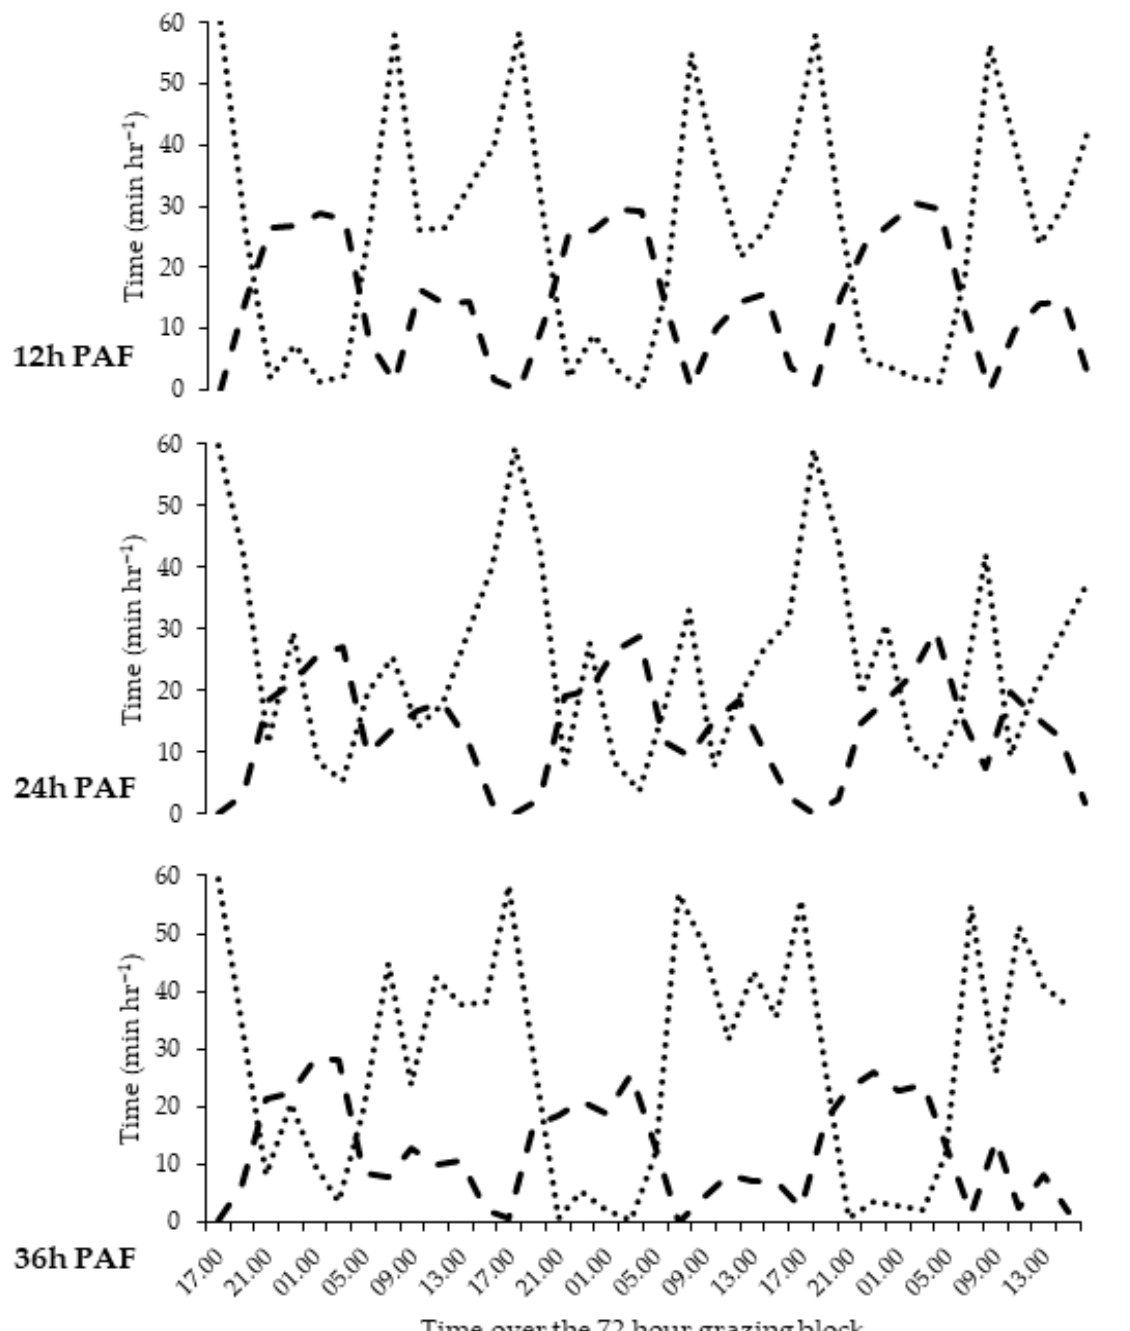
Figure 1. Impact of pasture allocation frequency (12, 24 or 36 h) on average grazing (dotted line, •••• ) and ruminating time (dashed line, - - - - ) during a 72 h grazing period.